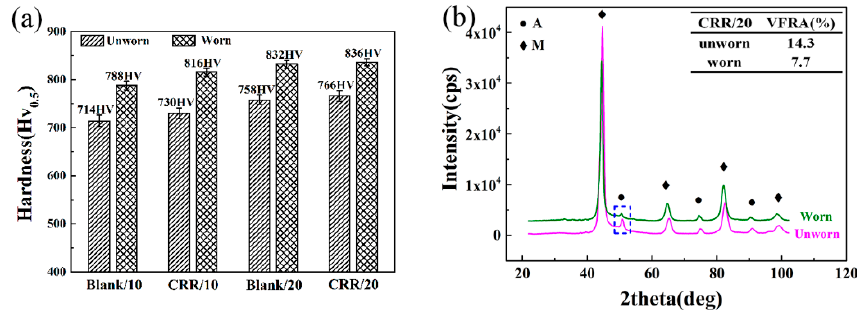
/ 20 specimen ( b ) before and after